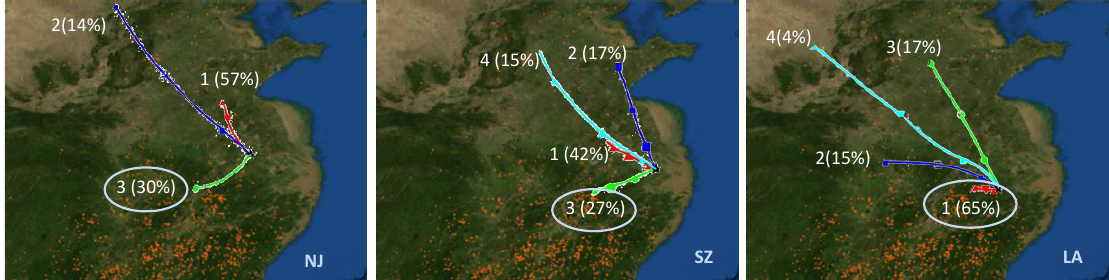
Figure 6. Cluster analysis of the 48-h backward trajectories combined with the fire map during the polluted period in NJ, SZ, and LA.